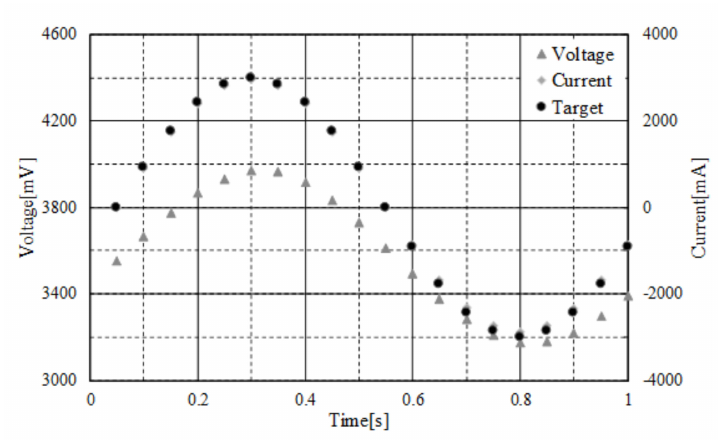
Figure 3. Voltage response of a secondary Li-Ion battery based on sinusoidal current.